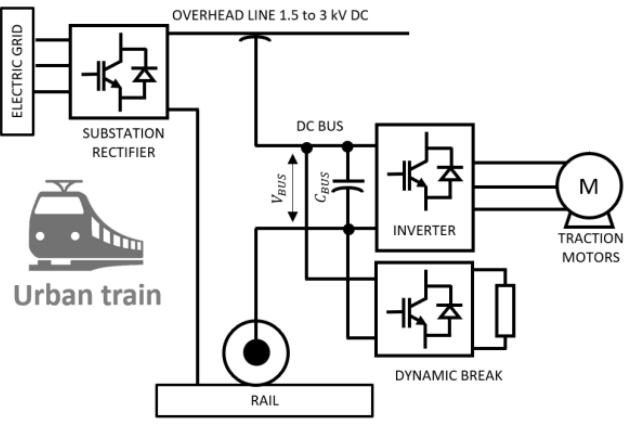
Figure 9. Simplified electrical diagram of the traction drive of light-railupplied vehicles.